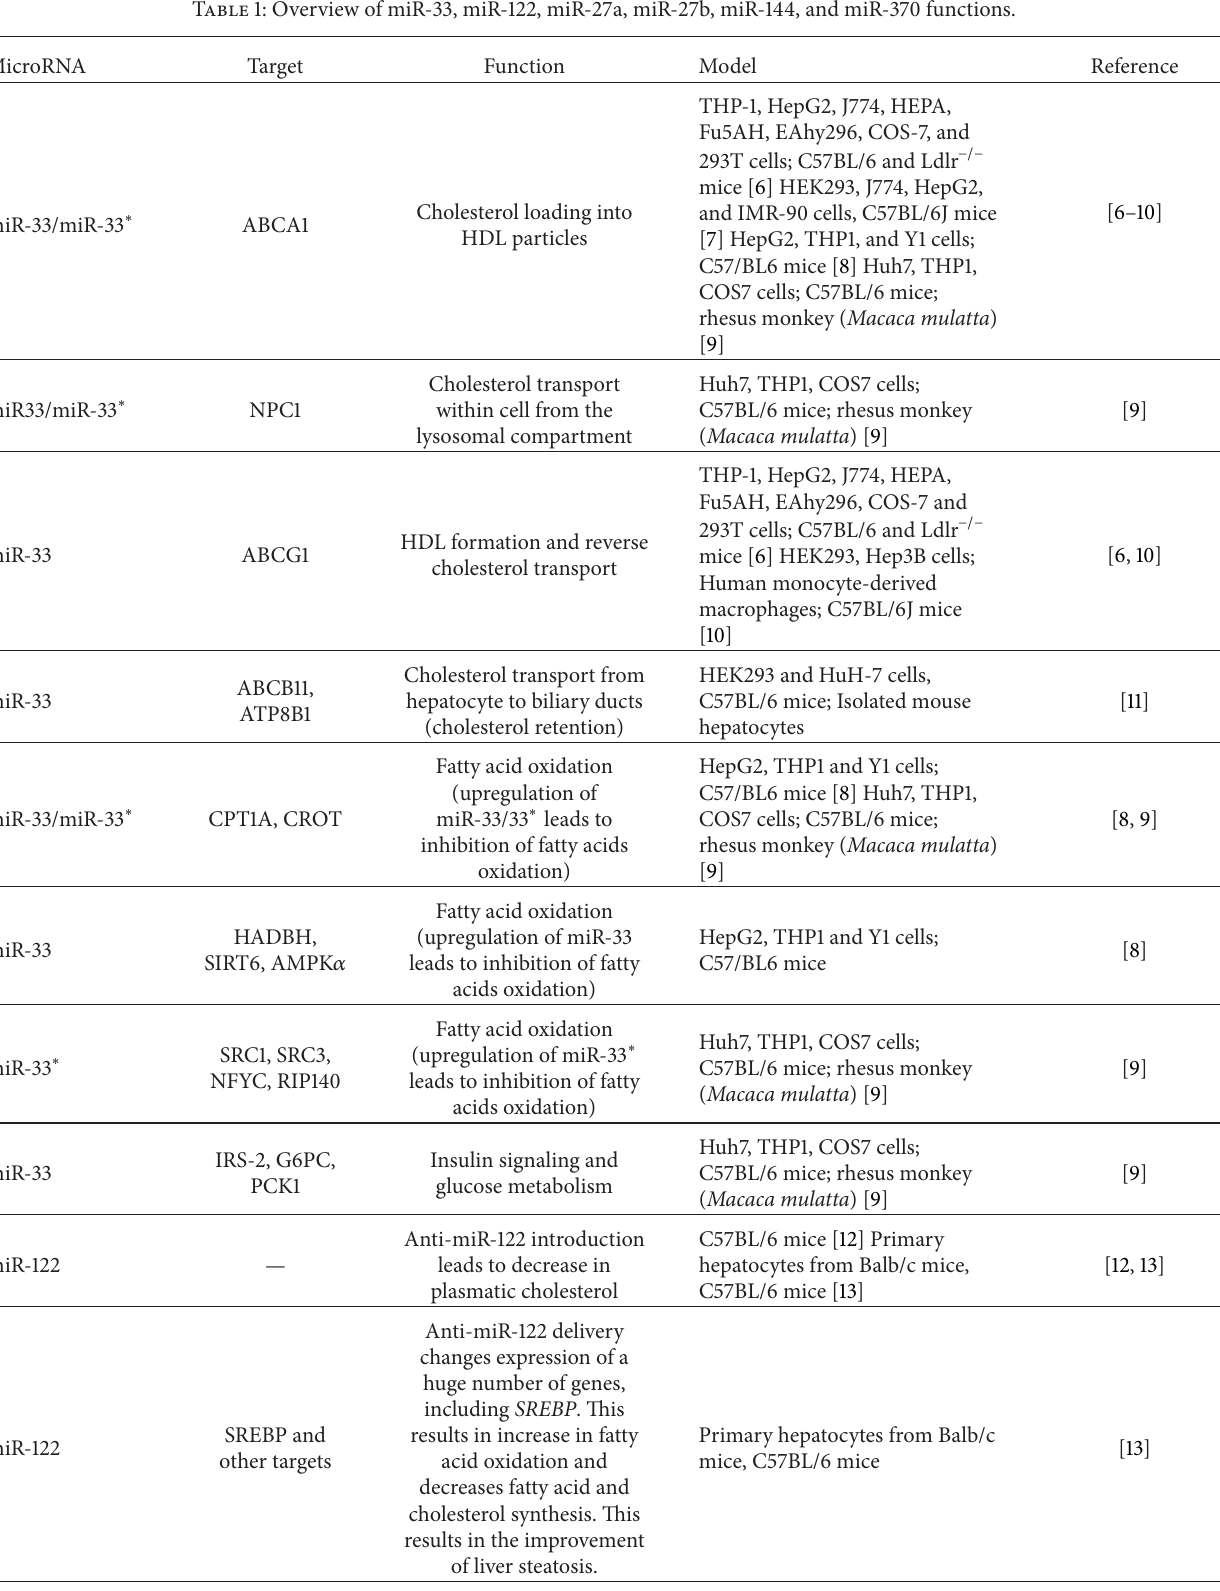
Table 1: Overview of miR-33, miR-122, miR-27a, miR-27b, miR-144, and miR-370